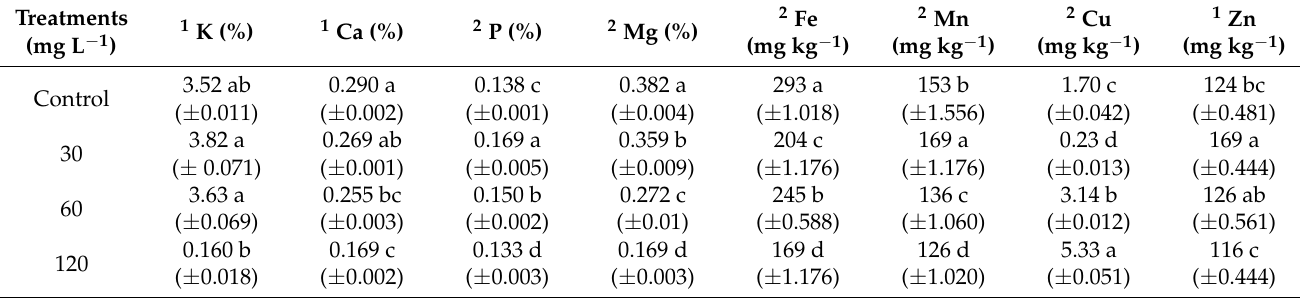
Values are the mean ± SE and values followed by the same letters in the same column were not significantly different by 1 Kruskal–Wallis Test and 2 Duncan’s test at 0.05 level. Control = 0.025 mg L − 1 and represents the concentration of CuSO 4 5H 2 O in MS medium (without copper sulphate